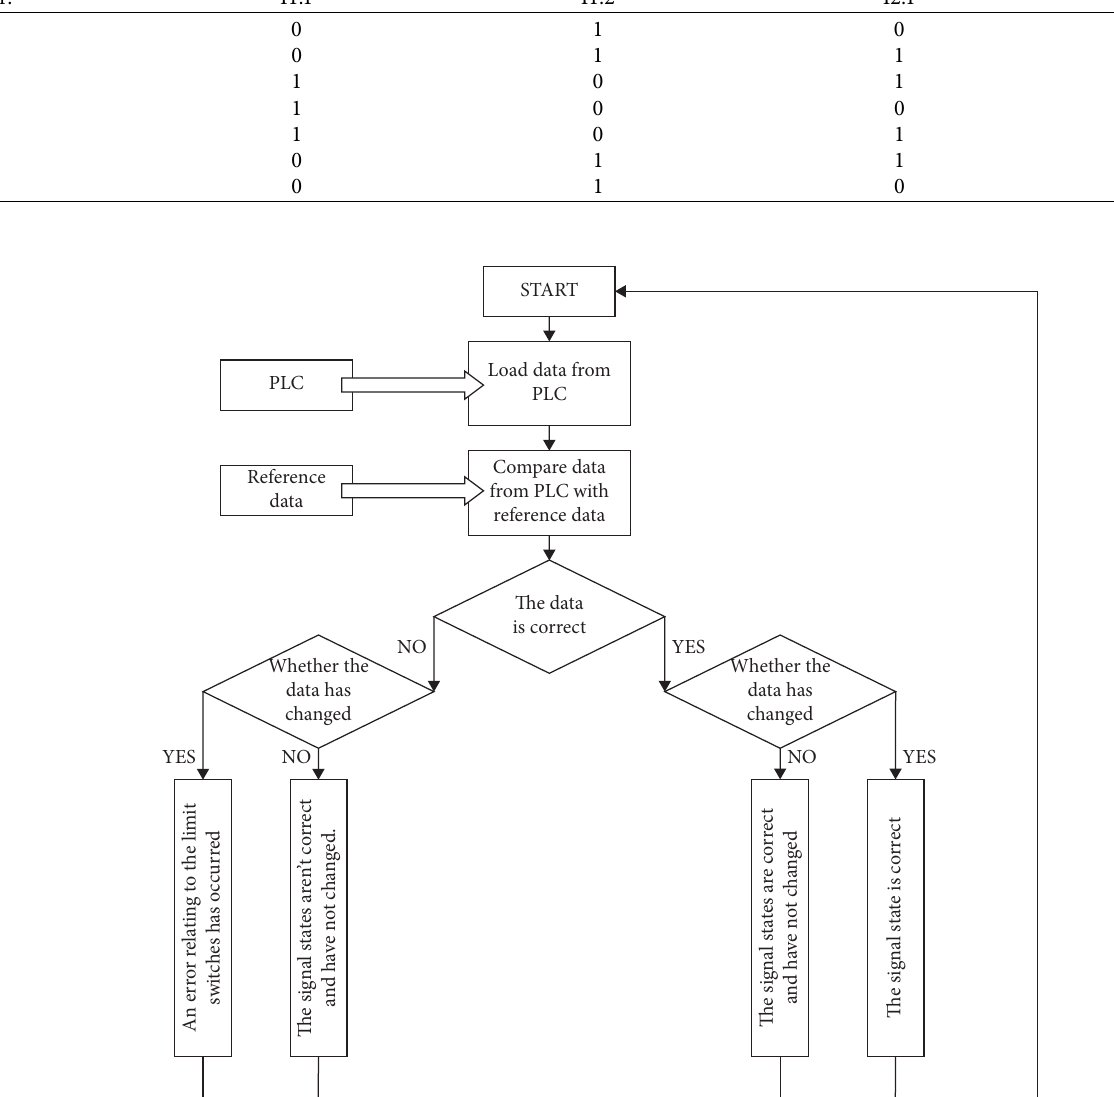
Table 1: Correct state of digital signals for particular positions of the manipulator. Nr. I1.1